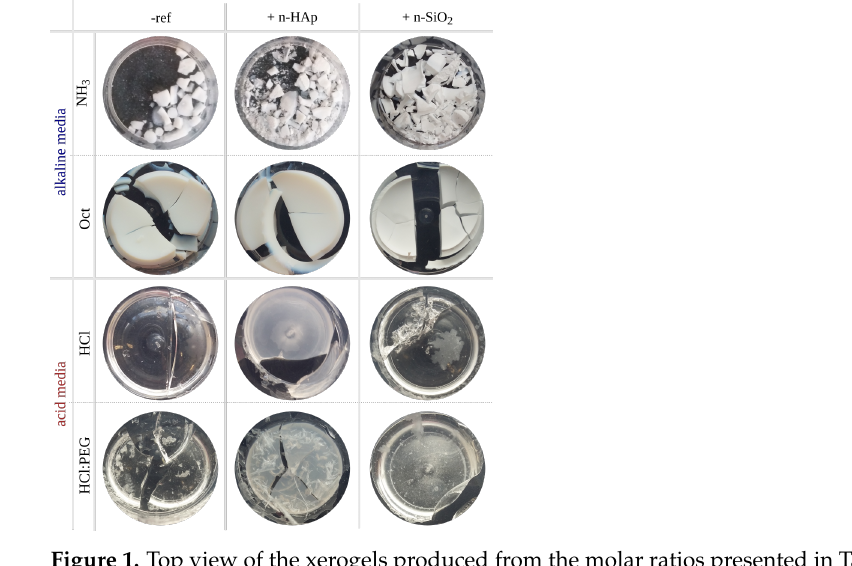
Figure 1. Top view of the xerogels produced from the molar ratios presented in Table